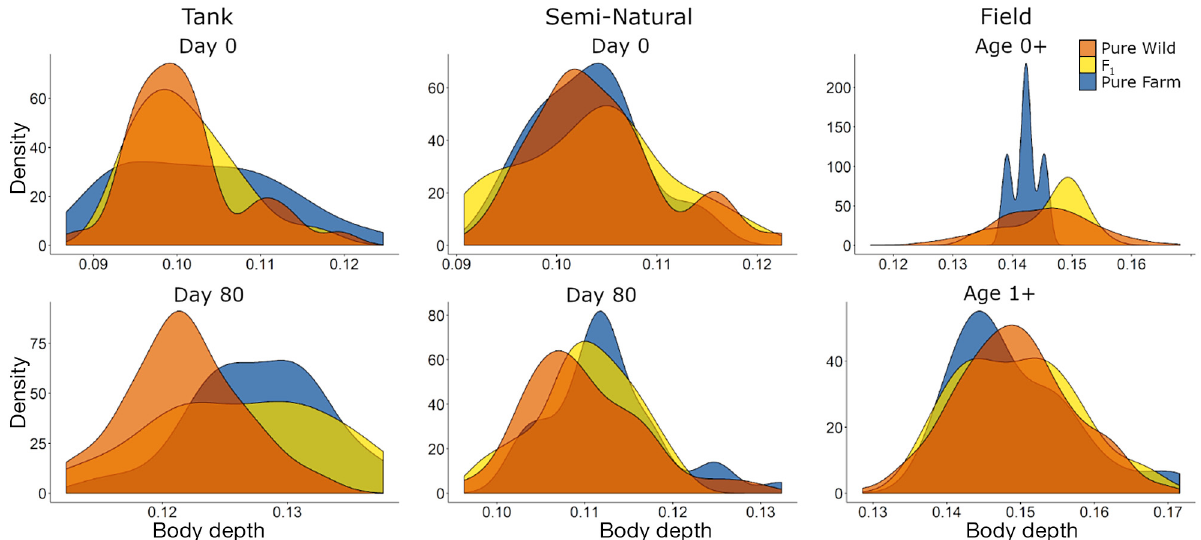
Fig. 4. Body-depth measurements using inter-landmark distance between landmarks 3 and 17. Landmarks are as illustrated in Fig. 1b. Individuals were measured on Day 0 (start) and Day 80 (end) post yolk absorption for the common garden experiment. Field salmon aged 0+ and 1+ were sampled from 18 rivers in southern Newfoundland as shown in Fig. 1. Identification of cross type of field sampled individuals was accomplished using genetic assignment and is described in Section 2